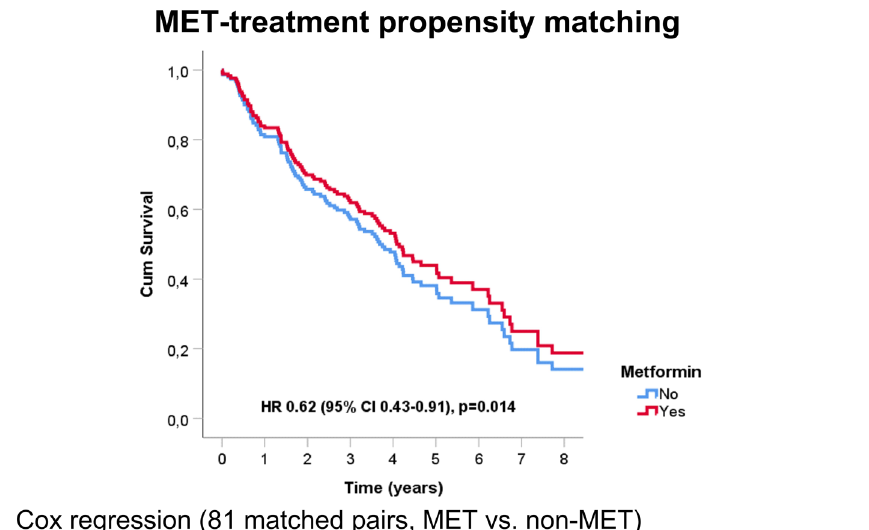
Figure 3. Survival of MET-treated patients, propensity-score matched analysis. BMI body mass index, eGFR estimated glomerular filtration rate, LVEF left ventricle ejection fraction, RV right ventricle, BNP